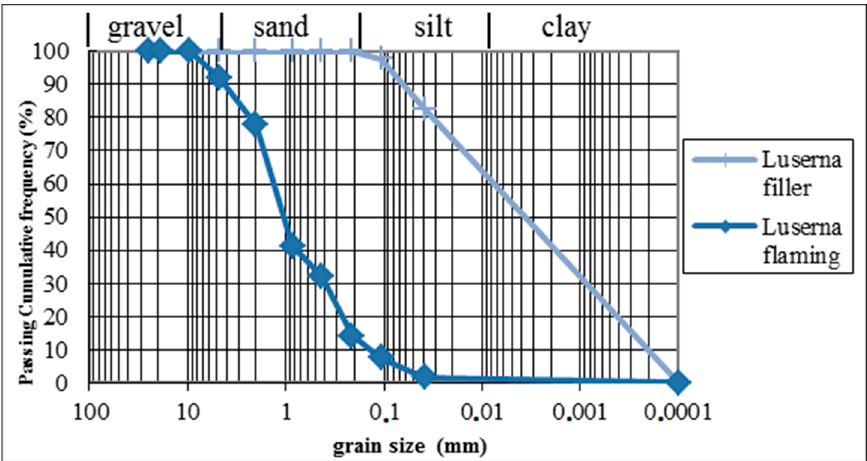
Figure 2. Particle size distribution analysis of two mix design components: Luserna filler from diamond blade sawing and Luserna sand from the flaming process.